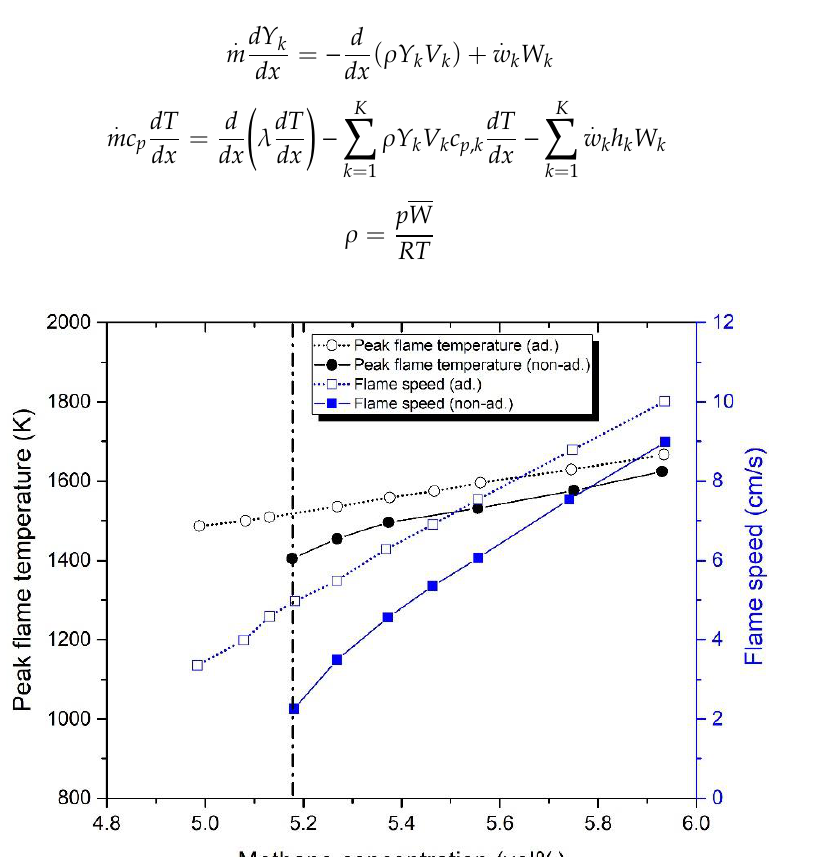
Figure 11. The calculated steady-state flame temperature and flame speed. Reproduced from Ref [81], The Combustion Institute: 1991.